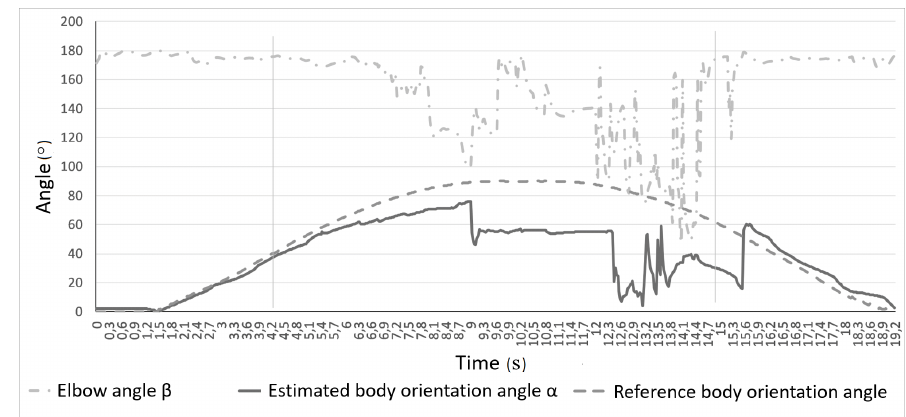
Figure 5. Elbow angle β estimation in relation to body rotation angle α